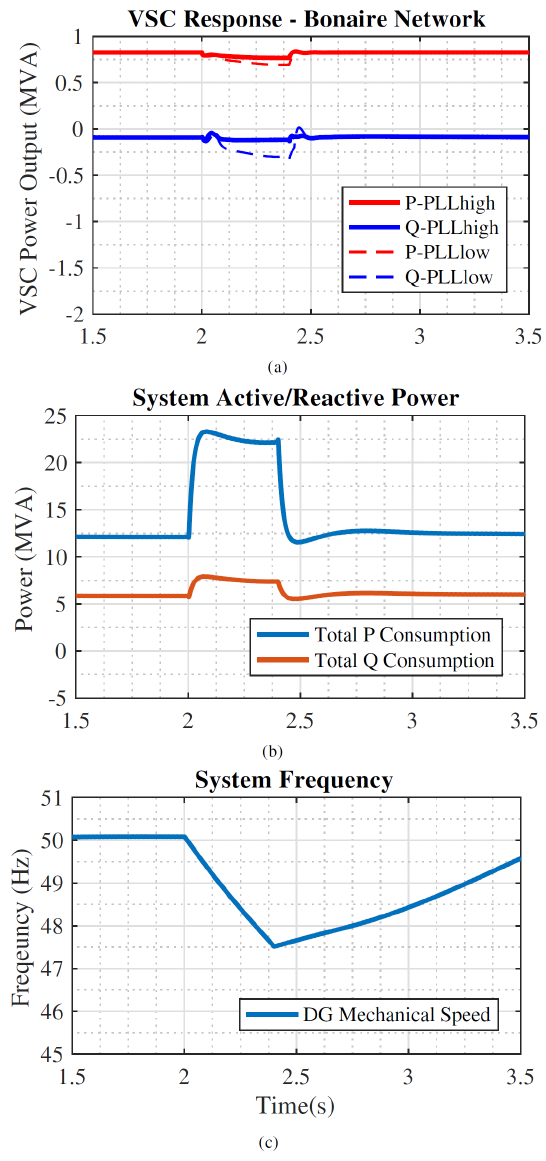
Figure 12. Simulation results with Bonaire island power network using different PLL control bandwidths—( a ) VSC power output ( b ) Total active/reactive power consumption ( c ) System frequency measured by the diesel generator mechanical